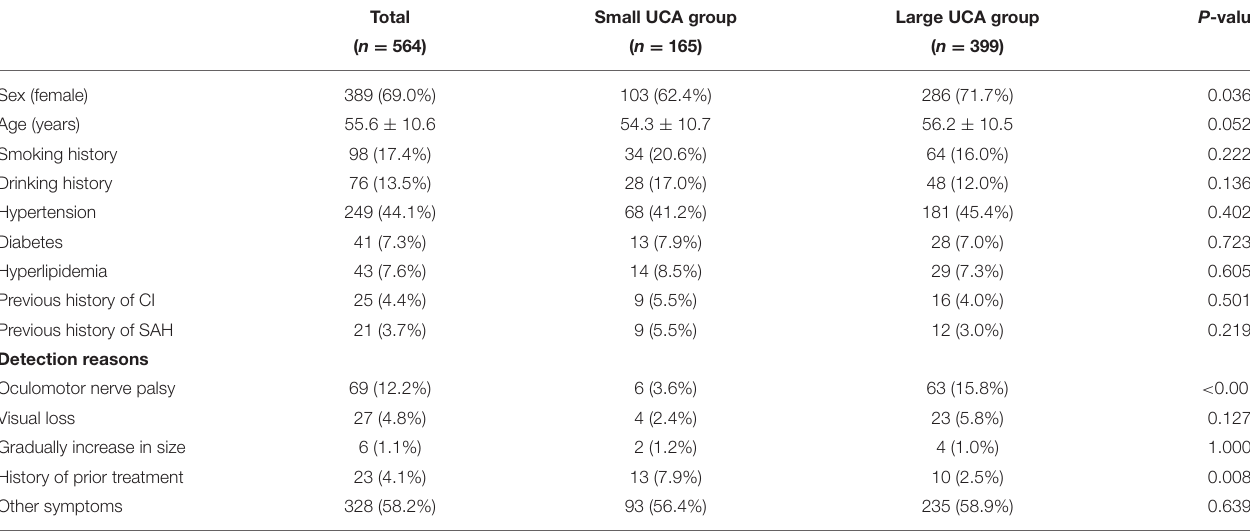
TABLE 1 | Clinical characteristics of patients with UCAs, divided into small and large UCA groups.